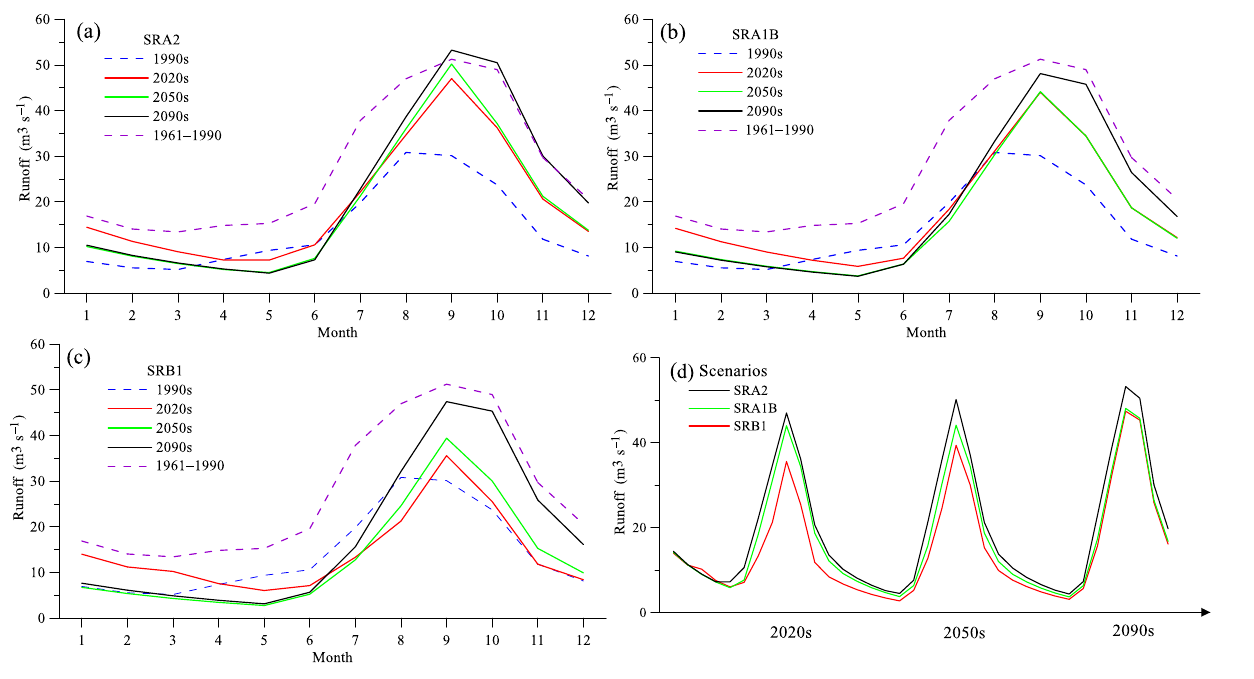
Figure 9. Projected runoff of different scenarios.